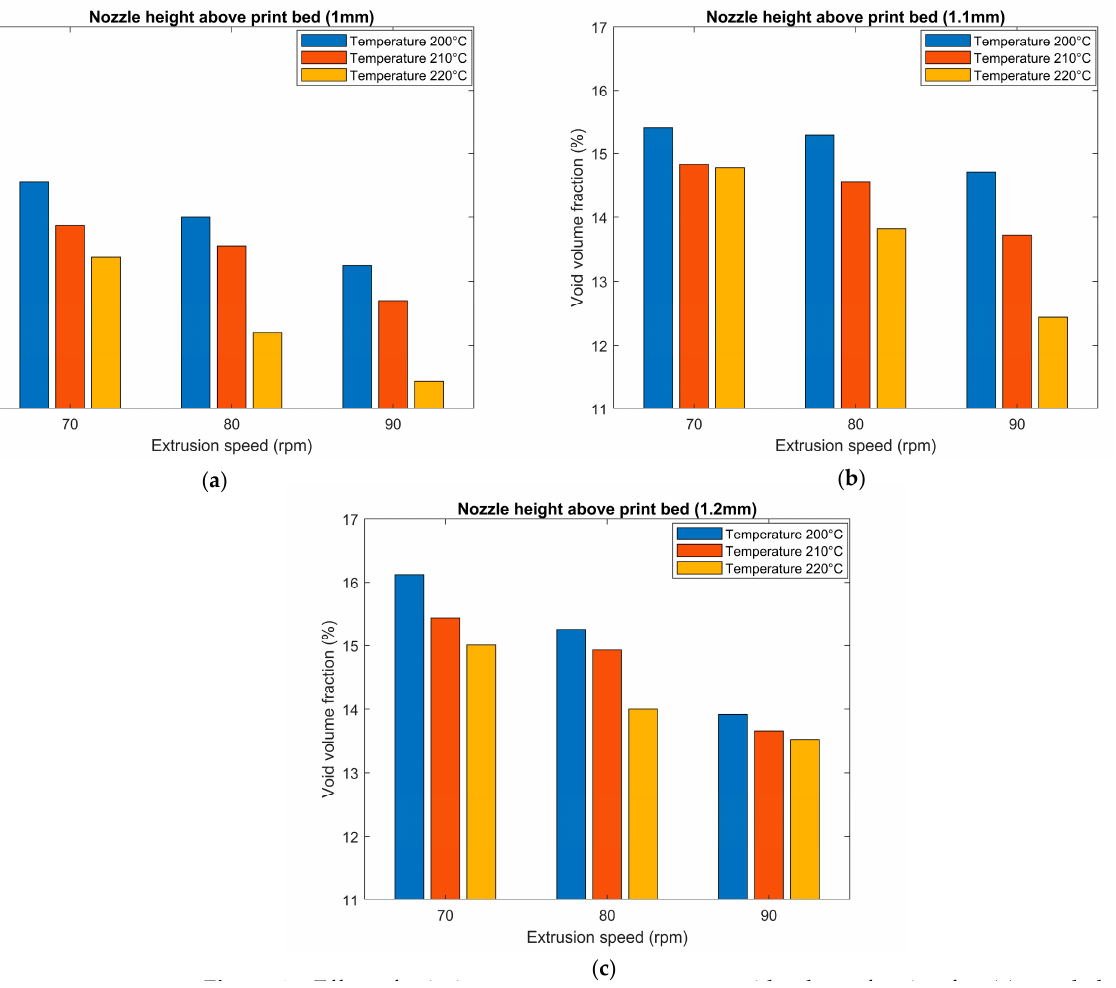
Figure 12. Effect of printing process parameters on void volume fraction for: ( a ) nozzle height (1 mm); ( b ) nozzle height (1.1 mm); ( c ) nozzle height (1.2 mm).